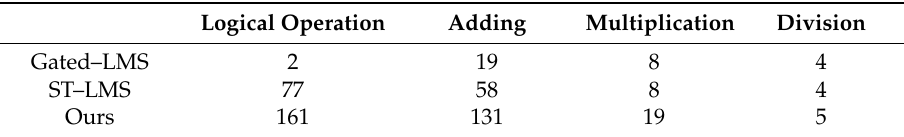
Table 2. The comparison of the computational resources per